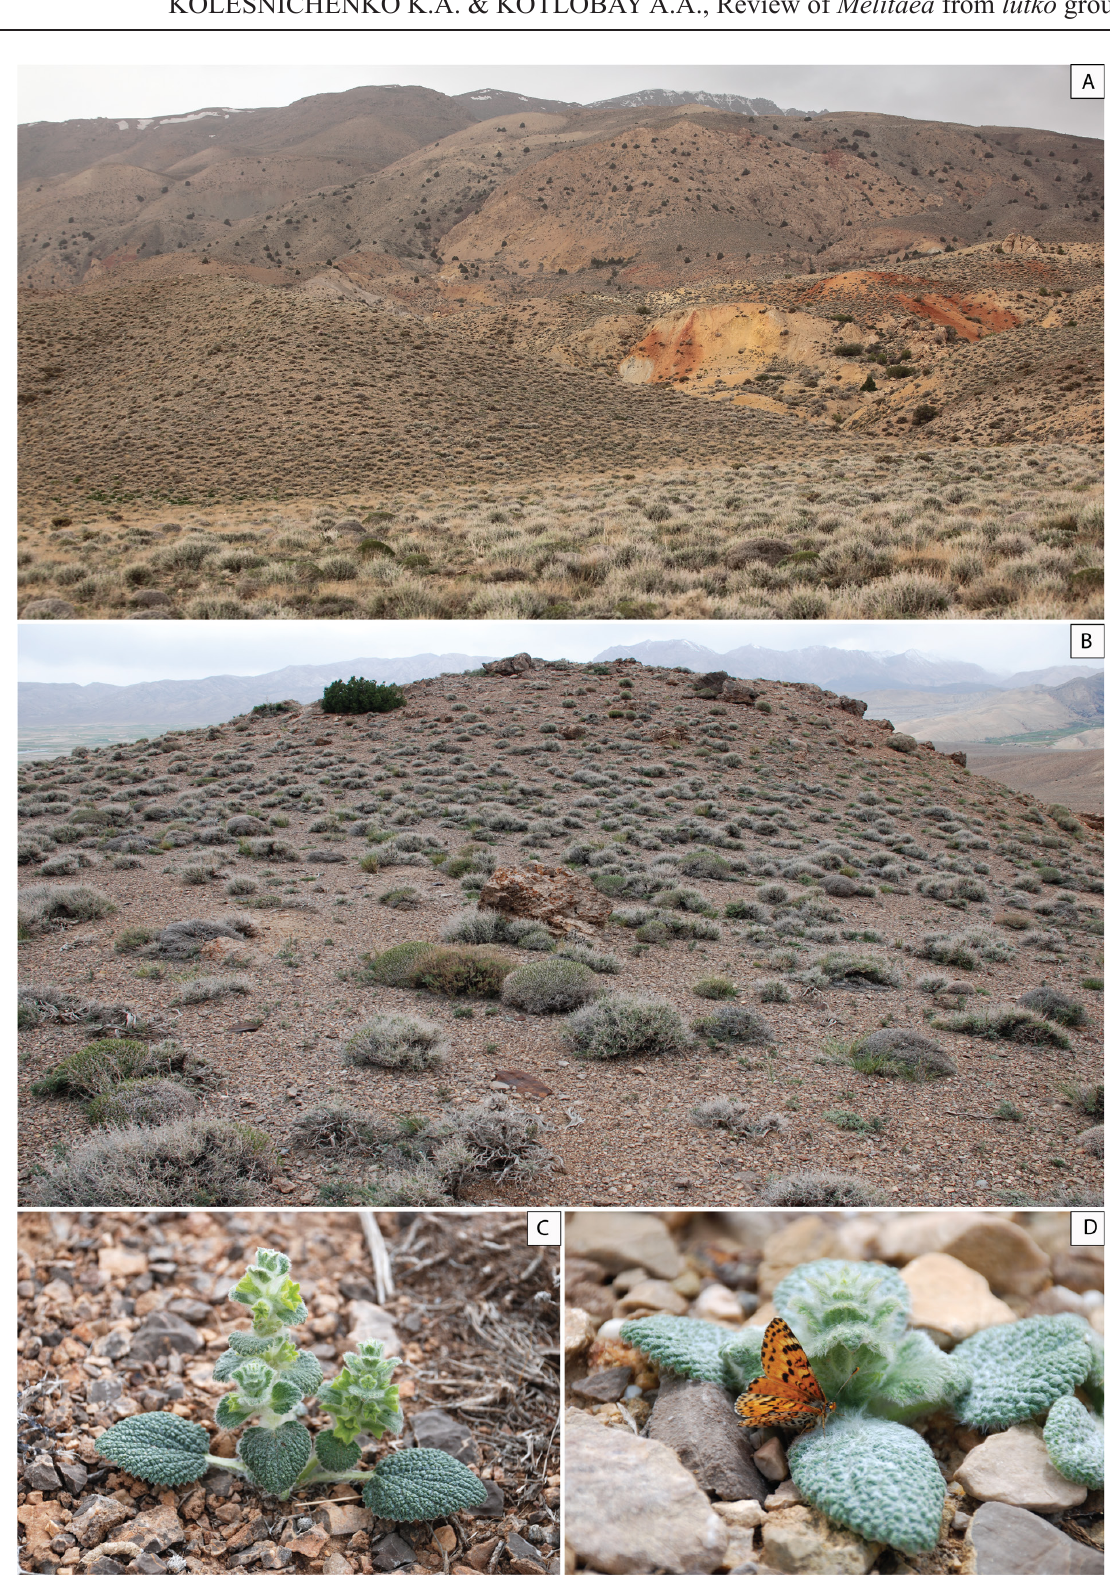
Fig. 27. Biotope, host plant, and adult of Melitaea shahvarica sp. nov. in nature. A . Shahvar Mt., E Elburs Ridge. B . Biotope with Phlomoides molucelloides (Bunge) Salmaki. C . Host plant Ph. molucelloides . D . Female on Ph. molucelloides